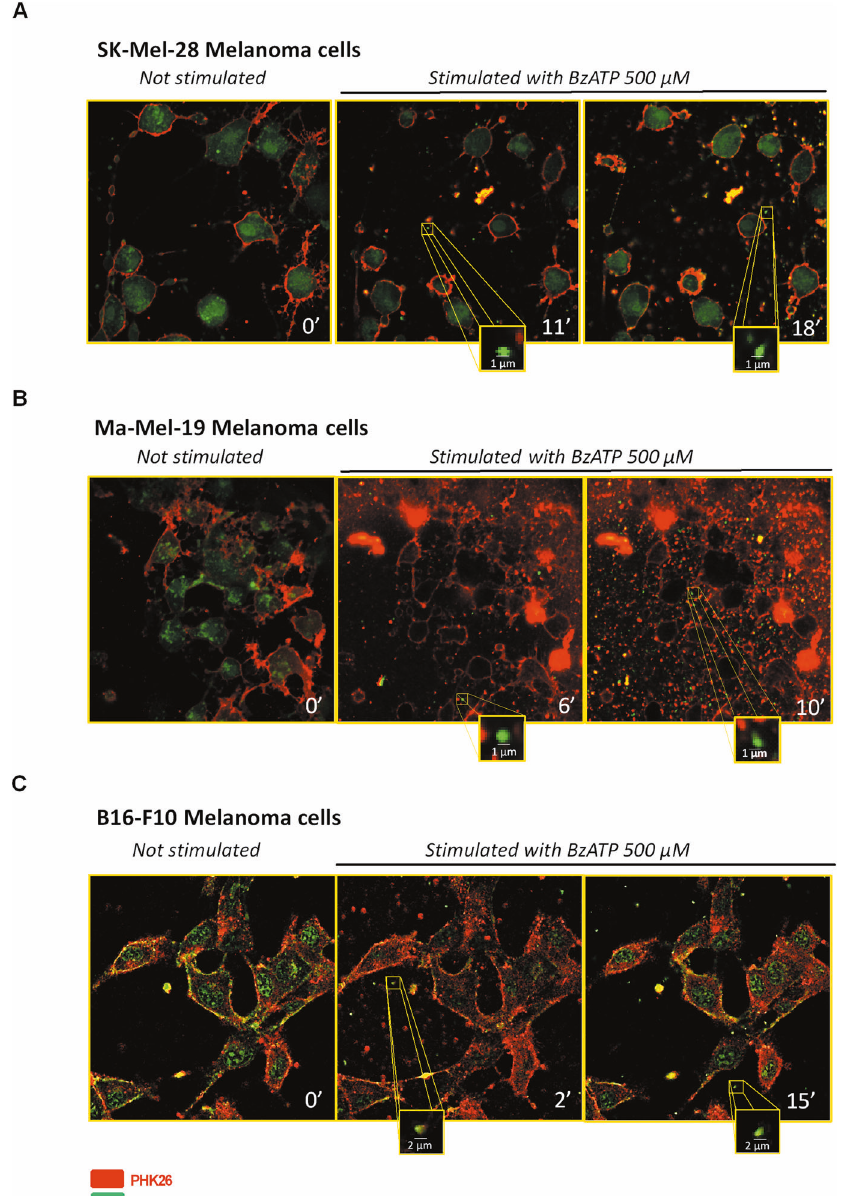
Fig. 5 Human and murine melanoma cells release vesicles upon stimulation of P2X7R. Representative images acquired with a confocal microscope of A Sk-Mel-28 cells, B Ma-Mel-19 cells, and C B16-F10 cells before and after stimulation with the P2X7 agonist BzATP (500 μ M). The plasma membrane was stained with the red dye PKH26GL, while nucleic acid content was labeled with